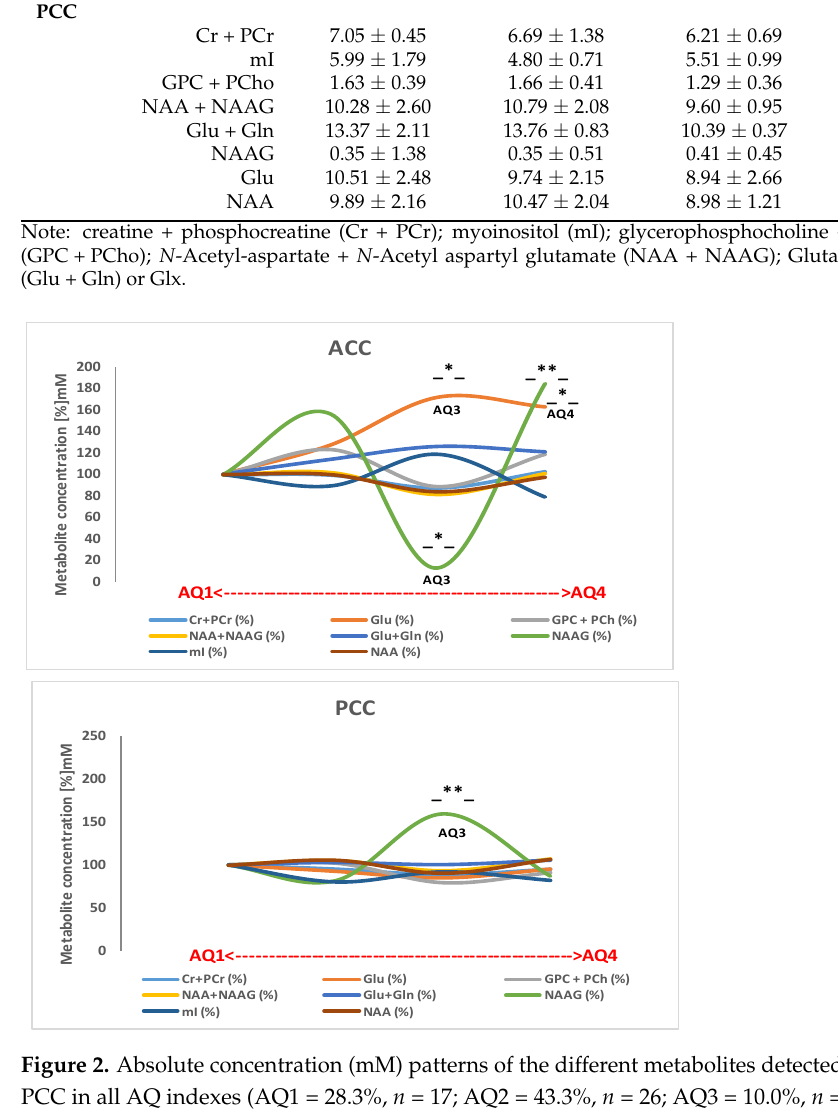
Table 4. Comparing the NAA/Cr, NAA/mI, and NAA/Cho ratios within the ASD ( n = 22) and TD ( n = 43) groups between the ACC and the PCC. p < 0.05 considered significantly different. Ratios NAA/Cr